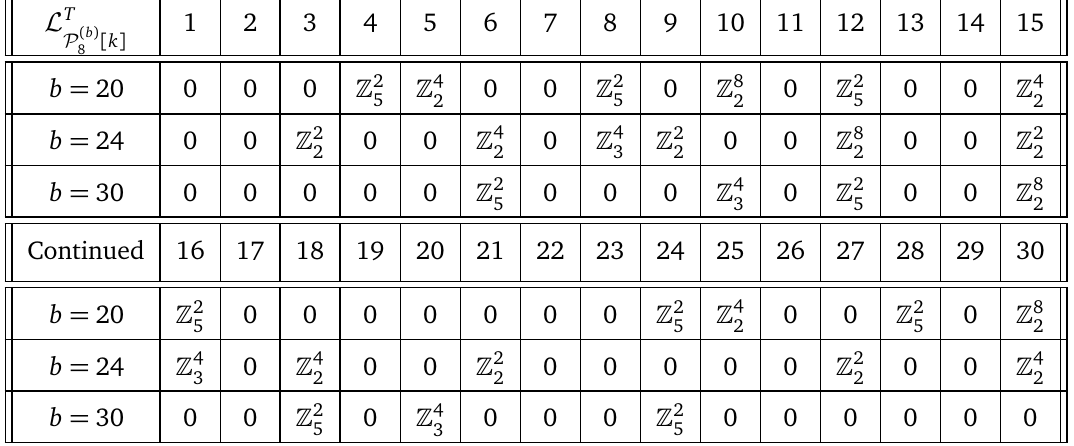
( b ) [ k ] of type E 8 8